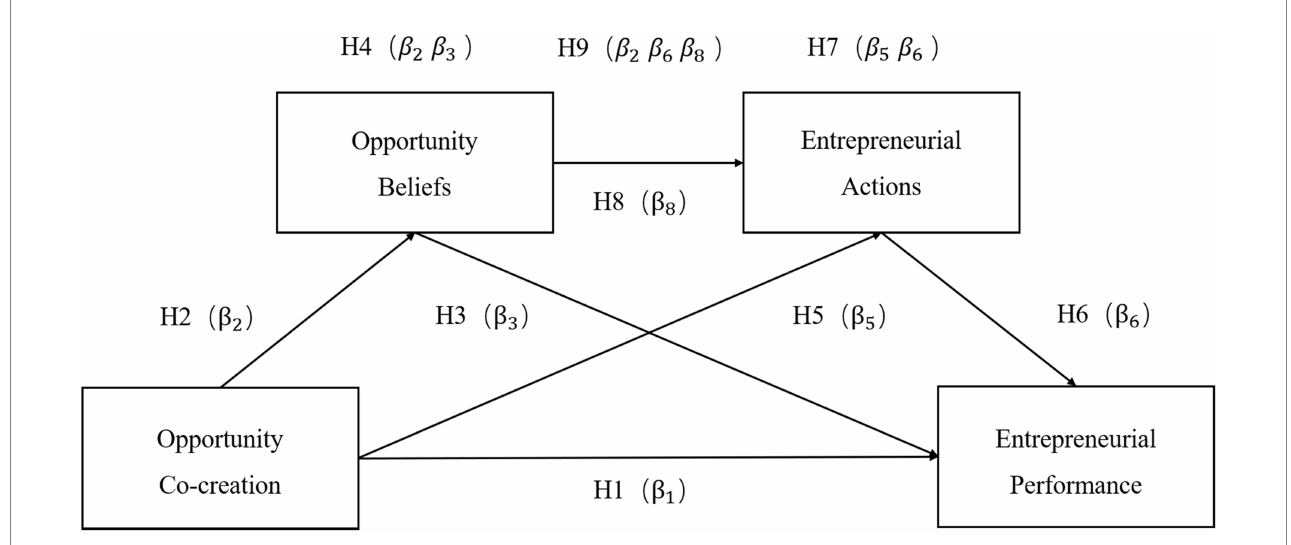
FIGURE 1 Research model. Italicized terms indicate mediating